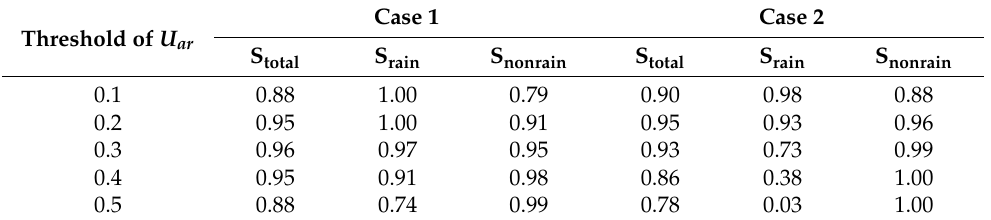
Table 3. Identification ratio of rain and nonrain layers using different thresholds of U ar